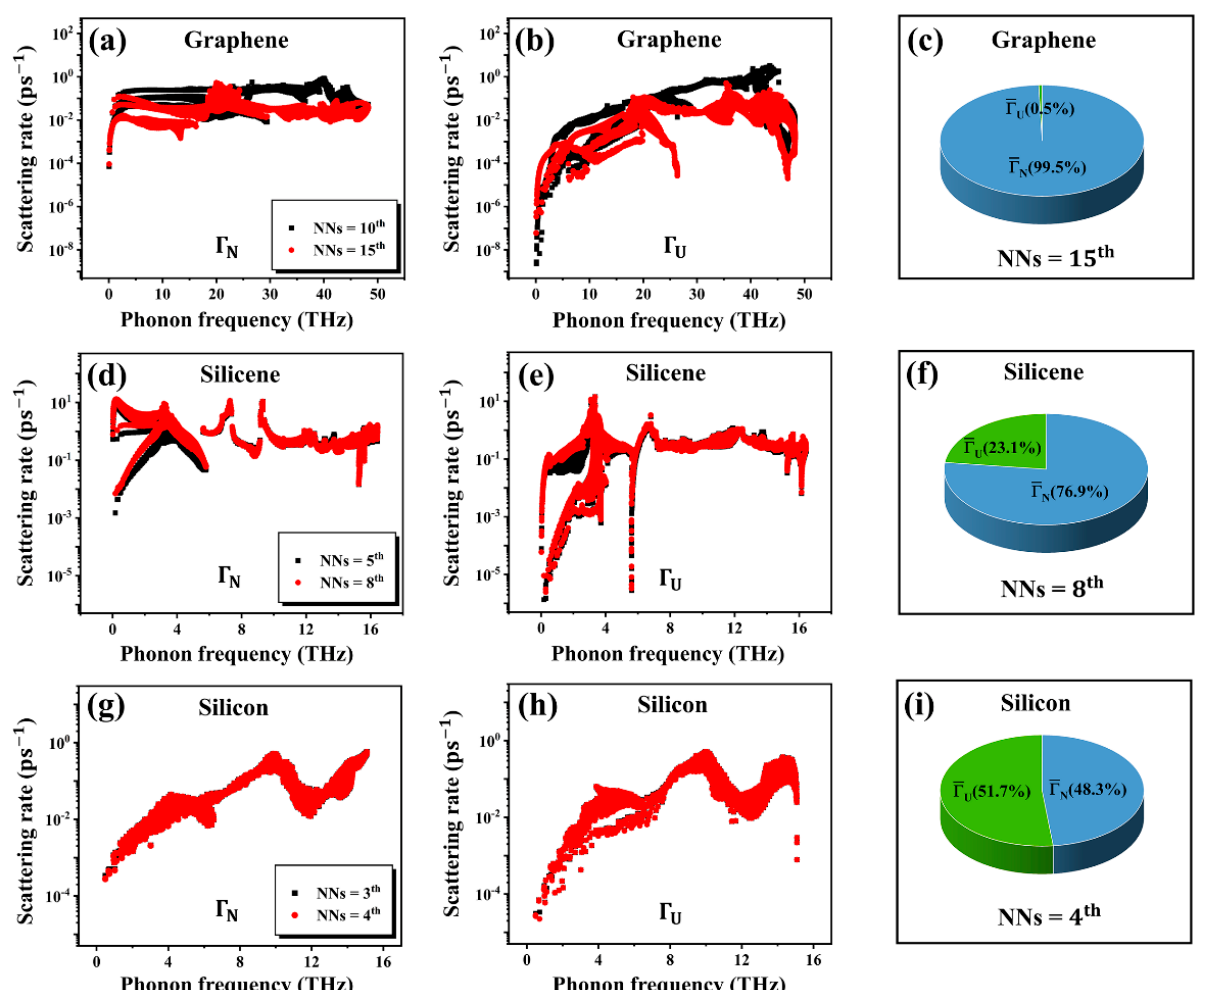
Figure 5. The frequency-resolved N-scattering rate ( Γ N ( ω ) ) and U-scattering rate ( Γ U ( ω ) ) at 300 K with different NNs in ( a , b ) graphene, ( d , e ) silicene, and ( g , h ) silicon. The ensemble-averaged scattering rates ( Γ N and Γ U ) for three acoustic phonons are shown in ( c ) graphene, ( f ) silicene, and ( i ) silicon,